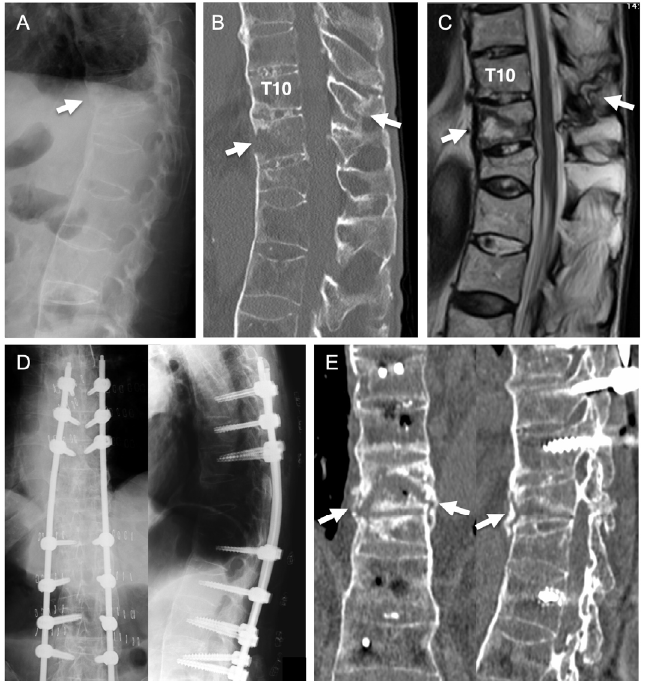
Figure 4. Illustrative case. Preoperative images showed spinal ankylosis and spinal fracture at the T10–11 levels (arrows in ( A – C )). PPS fixation with augmentation using HA granules was performed ( D ). Bone union at the fracture site was achieved at 12 months after surgery (arrows in ( E )).